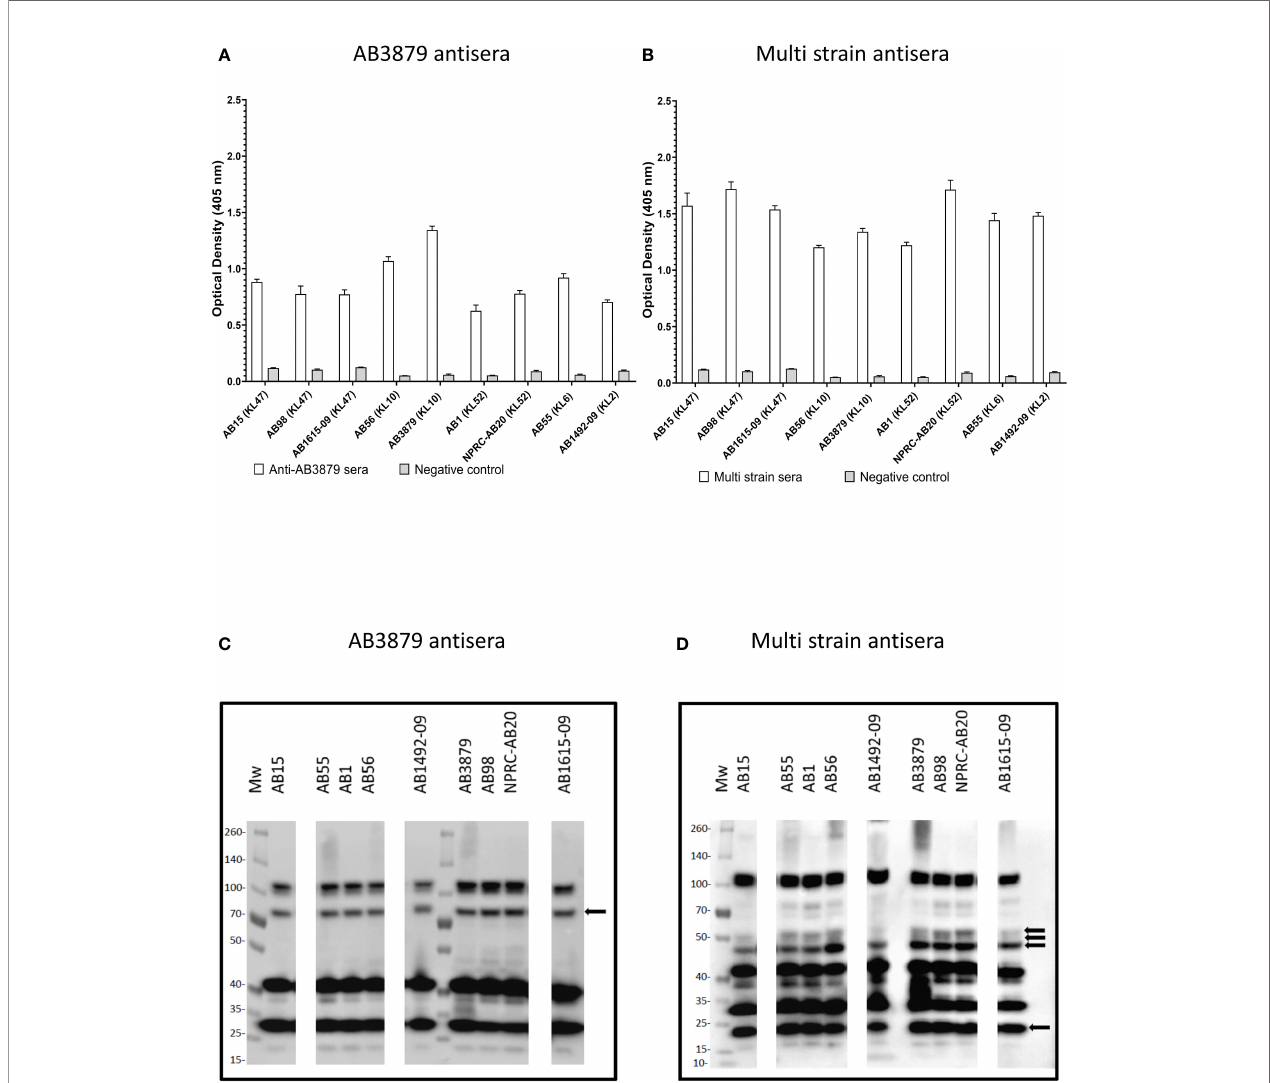
FIGURE 1 | Whole cell ELISA and immunoblot detection of the reactivity of mouse antisera with A. baumannii isolates. Whole cell ELISAs of IgG binding to nine A. baumannii isolates using either AB3879 (A) or multi strain antisera (B) . Whole cell lysates from the nine diverse A. baumannii isolates were resolved on a reduced 4- 12% gradient gel, probed with mouse antisera and anti-mouse IgG-HRP. Each lane represents a clinical A. baumannii isolate indicated above. Immunoreactive proteins detected when blot was probed with either AB3879 (C) or multi strain antisera (D) . Black arrows represent bands unique to immunoblots probed with either AB3879 or multi strain sera. Bars represent mean values for each group and the error bars indicate standard deviations (SDs) (n = 3). Representative data from two independent experiments is